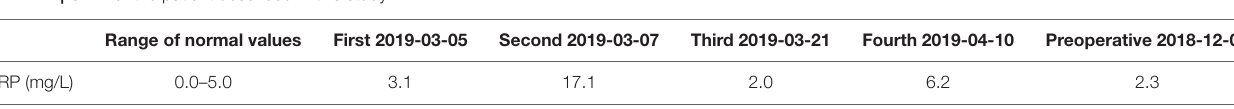
TABLE 2 | CRP for the patient described in this study.